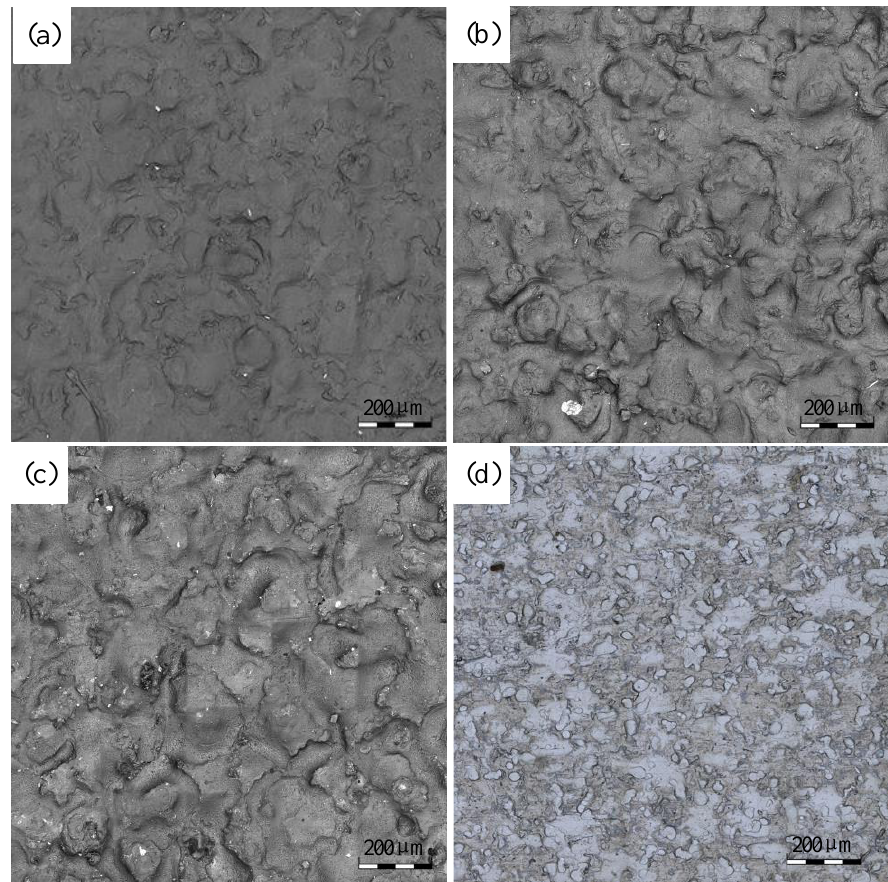
Figure 3. Initial surface topography: ( a ) the S a of roll 3 µ m, ( b ) the Sa of roll 3.5 µ m, ( c ) the S a of roll 4 µ m, ( d ) the strip before rolling. Micromachines 2020 , 11 , x